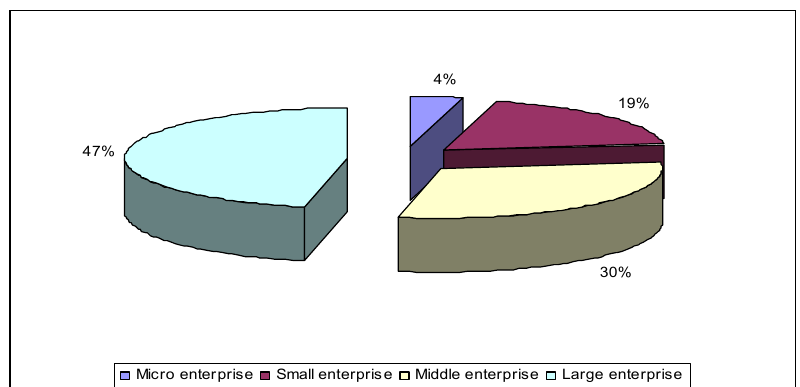
Figure 1 – Structure of organisations according to